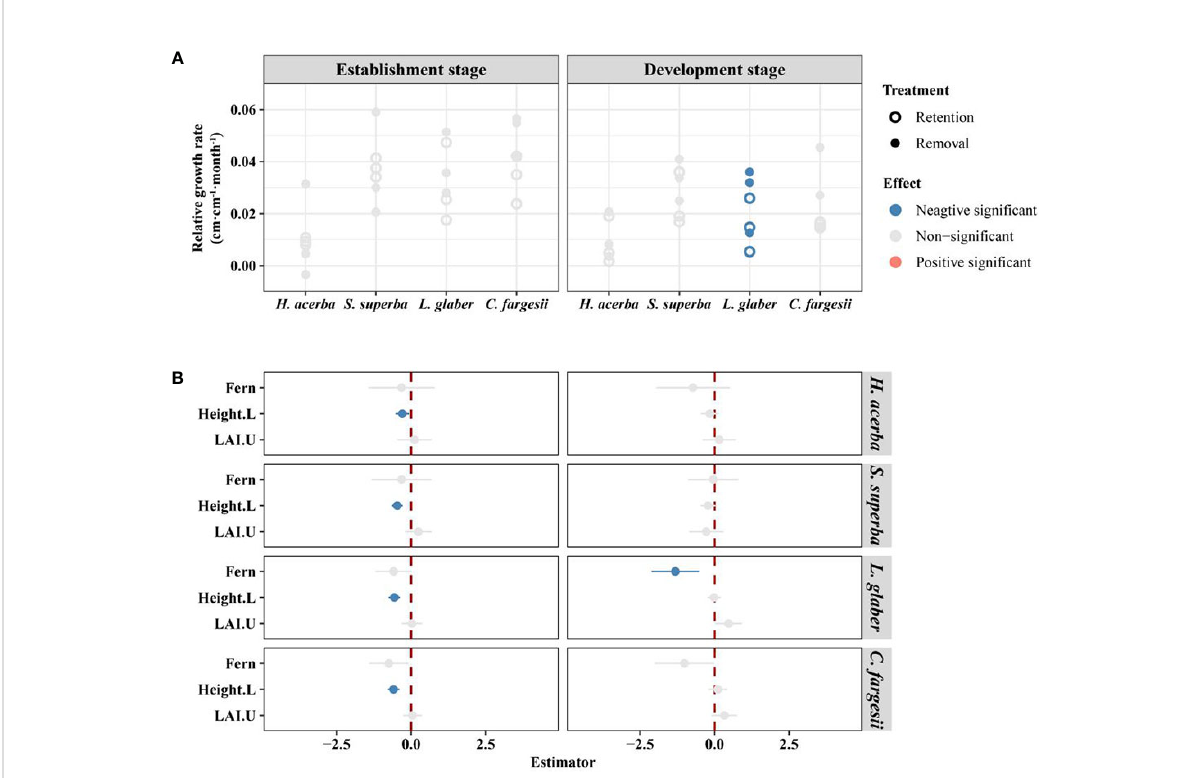
FIGURE 3 The difference in relative growth rate of living seedlings between retention and removal treatments in establishment and development stages (A) , and the corresponding estimator of explanatory variables in linear mixed-effects models (B) . Fern in B refers to the effect of retention treatment vs removal treatment; Height.L refers to the log-transformed height of seedling in the last census; LAI.U is the leaf area index of the plot in the understory. The error bars in B represent 1.96*se around estimator in linear mixed models. Blue and red points in B indicate parameter estimates signi fi cantly different from zero at the alpha = 0.05